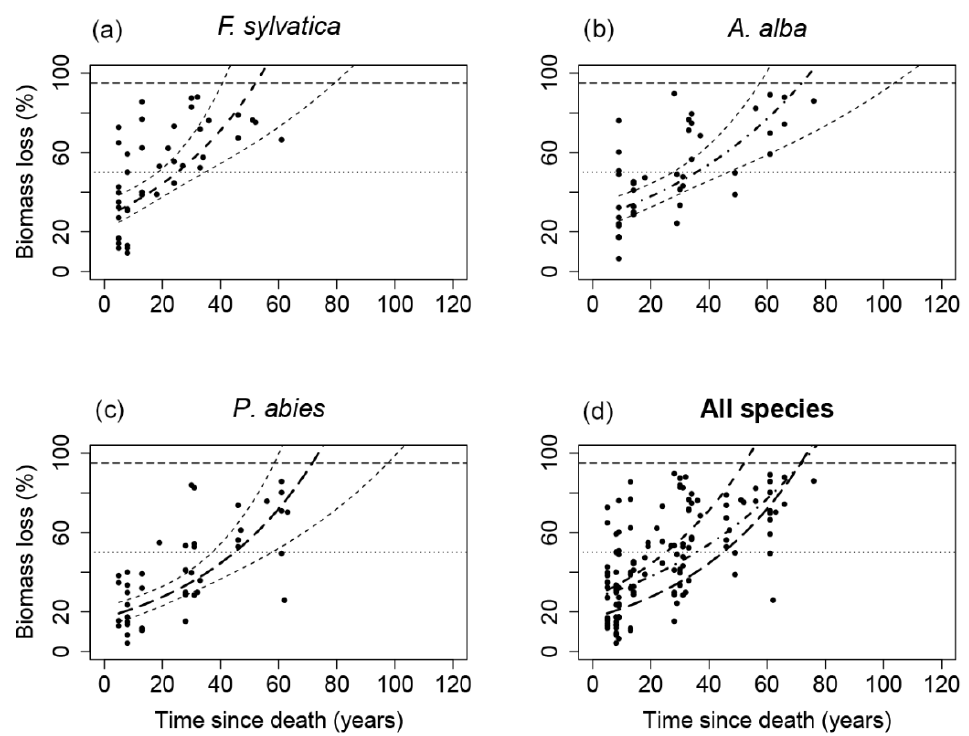
Figure 5. Exponential models of the decomposition rate and half-life based on the biomass loss of downed logs for each tree species ( a ) F. sylvatica ; ( b ) A. alba ; ( c ) P. abies . ( d ) Logs of all tree species together with the line type according to the tree species: dashed line— F. sylvatica ; dash-dotted line— A. alba ; long-dashed line— P. abies .